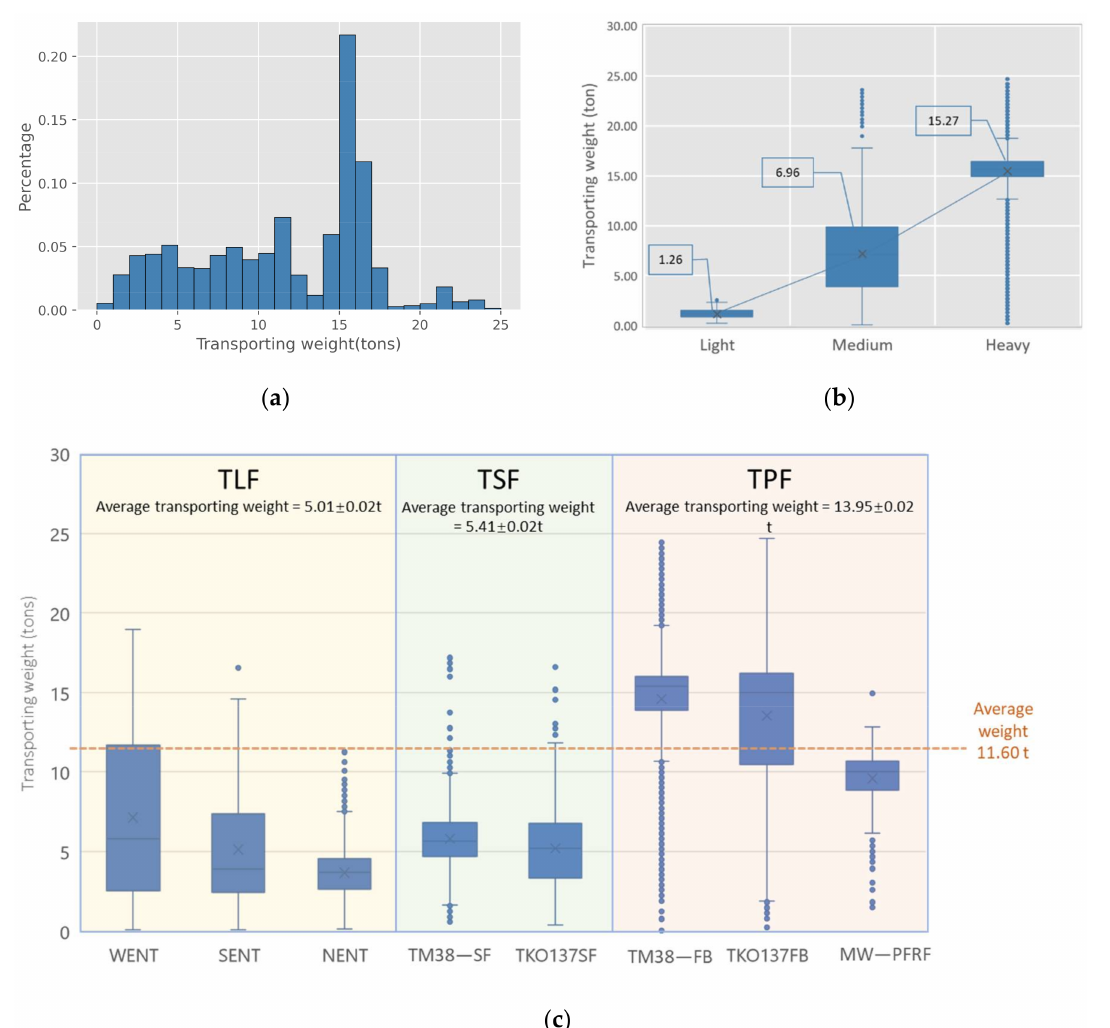
Figure 5. Transporting weight of CWHTs: ( a ) transporting weight histograms of CWHTs; ( b ) transport- ing weight distribution by vehicle types; ( c ) transporting weight distribution by freight trip types. Notes: Average transporting weight in ( c ) is presented as mean value ± SEM (standard error of the